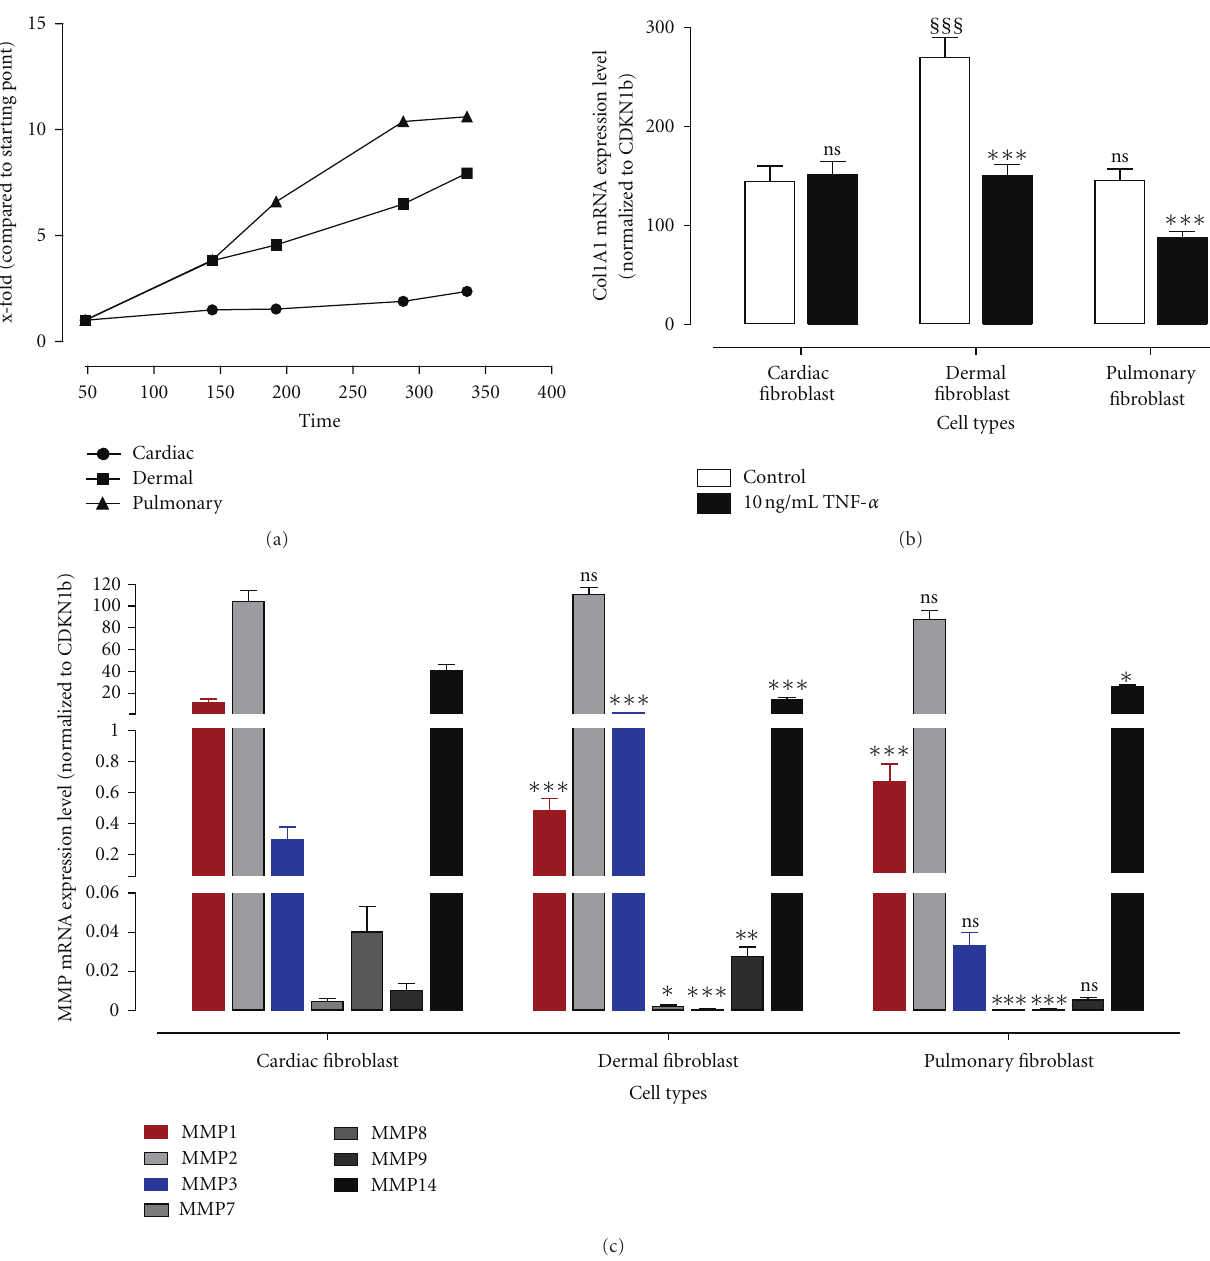
Figure 2: Proliferation, collagen expression, and basal MMP expression of cardiac, dermal, and pulmonary fibroblasts. (a) Growth curves were determined in complete growth medium for fibroblasts derived from heart, skin, and lung. Cardiac fibroblasts reveal a lower proliferation rate compared to dermal and pulmonary fibroblasts. (b) Collagen mRNA expression level was determined using TaqMan from fibroblasts incubated with or without 10ng/mL TNF- α for 24 hours. Untreated dermal fibroblasts show a significantly higher expression level of collagen ( §§§ ) compared to untreated cardiac and pulmonary fibroblasts, whereas only in dermal and pulmonary fibroblasts TNF- α treatment resulted in significantly decreased collagen expression compared to untreated controls ( ∗∗∗ ). (c) Basal expression levels of di ff erent MMPs in dermal and pulmonary fibroblasts were compared to their expression in cardiac fibroblasts. The most obvious di ff erence is shown for MMP1 and MMP3. All mRNA expression levels are shown as absolute expression using the formula 2 − Δ Ct